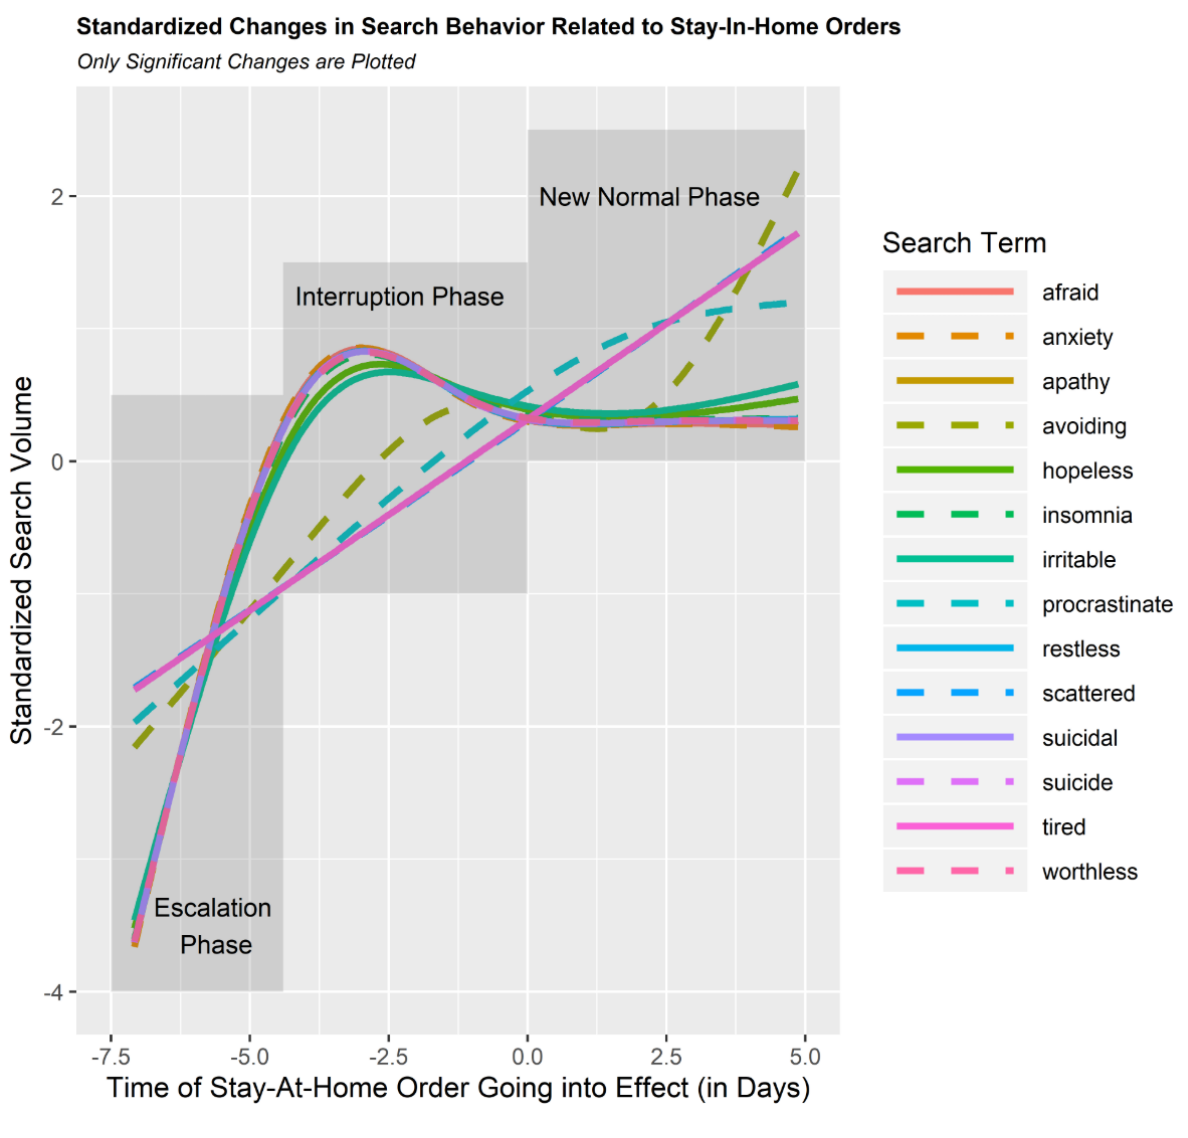
Figure 4. This plot depicts the standardized changes in search patterns relative to the orders going into effect. Values are normalized to reflect the relative change in these searches across time. Negative time of stay-at-home values reflect the time before the stay-at-home orders go into effect, and positive values reflect the time following the order going into effect. Values are standardized to show the relative pattern of the effect. The escalation phase designates approximately 4 days prior to the stay-at-home orders going into effect. The interruption phase spans between approximately 4 days and 0 days before the orders go into effect, and the new normal phase represents the times the 5 days after orders go into